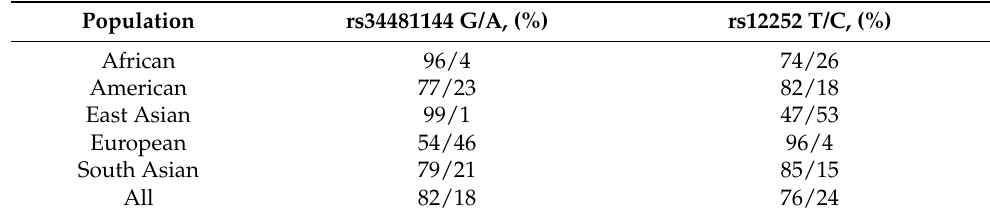
Figure 3. The proposed mechanism to explain IFITM3 rs12252 participation in influenza A virus (IAV) infection. Created with BioRender.com. Table 1. Different IFITM3 single nucleotide polymorphism (SNP) allele distribution by